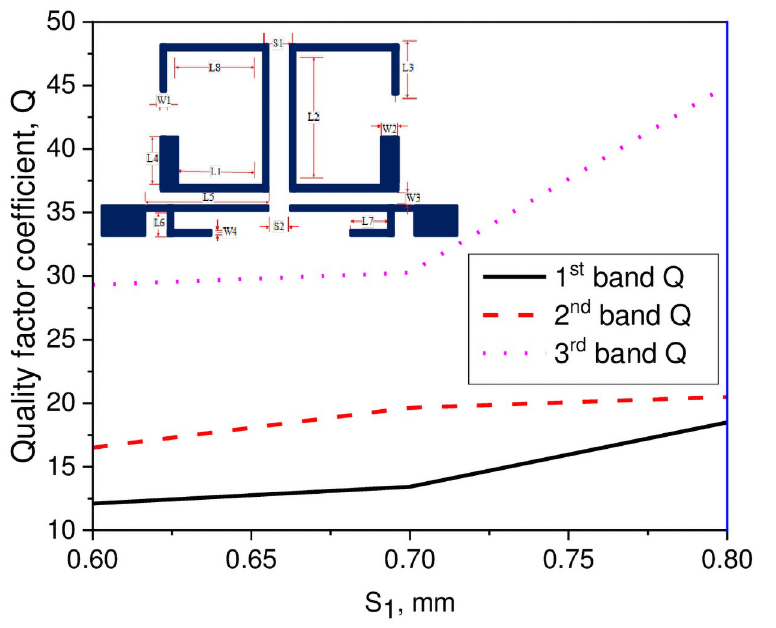
Fig 5. Graph of quality factor coefficient with S 1